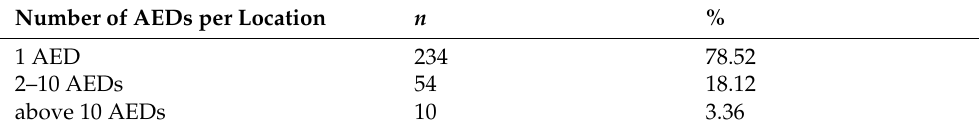
Table 2. A number of AED devices per unit ( n =